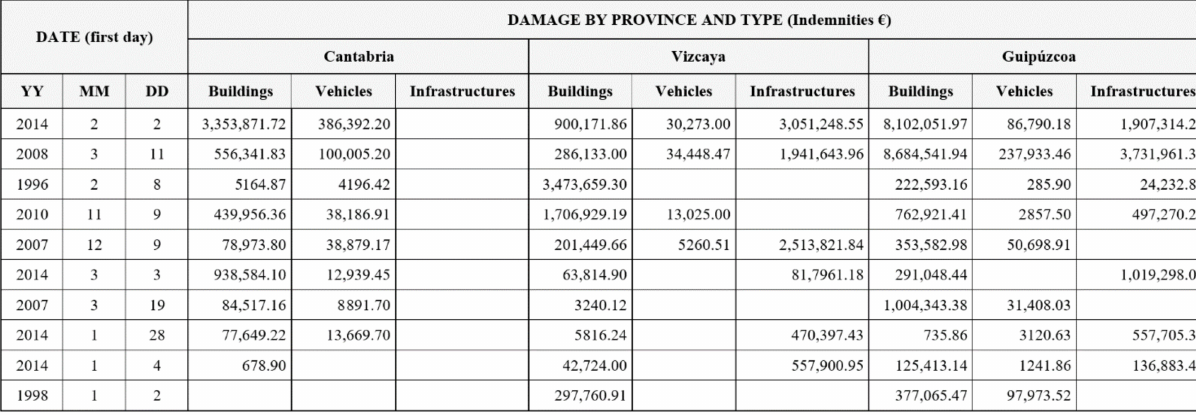
Figure 4. Extract from the inventory of damaging storms. Indemnity data for the 10 major damaging wave